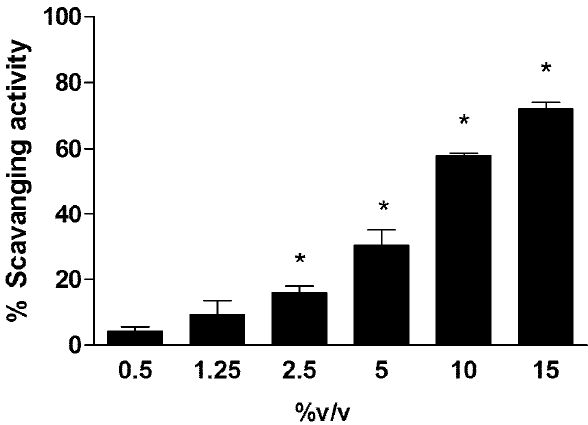
Figure 1. Antioxidant capability of Rapha Myr ® extract (0.5–1.25–2.5–5–10–15% v/v ) evaluated by DPPH assay. The scavenging activity was expressed as percentage decrease in absorbance with respect to control. Values are mean ± SD of three experiments in triplicate. * p < 0.05 vs.